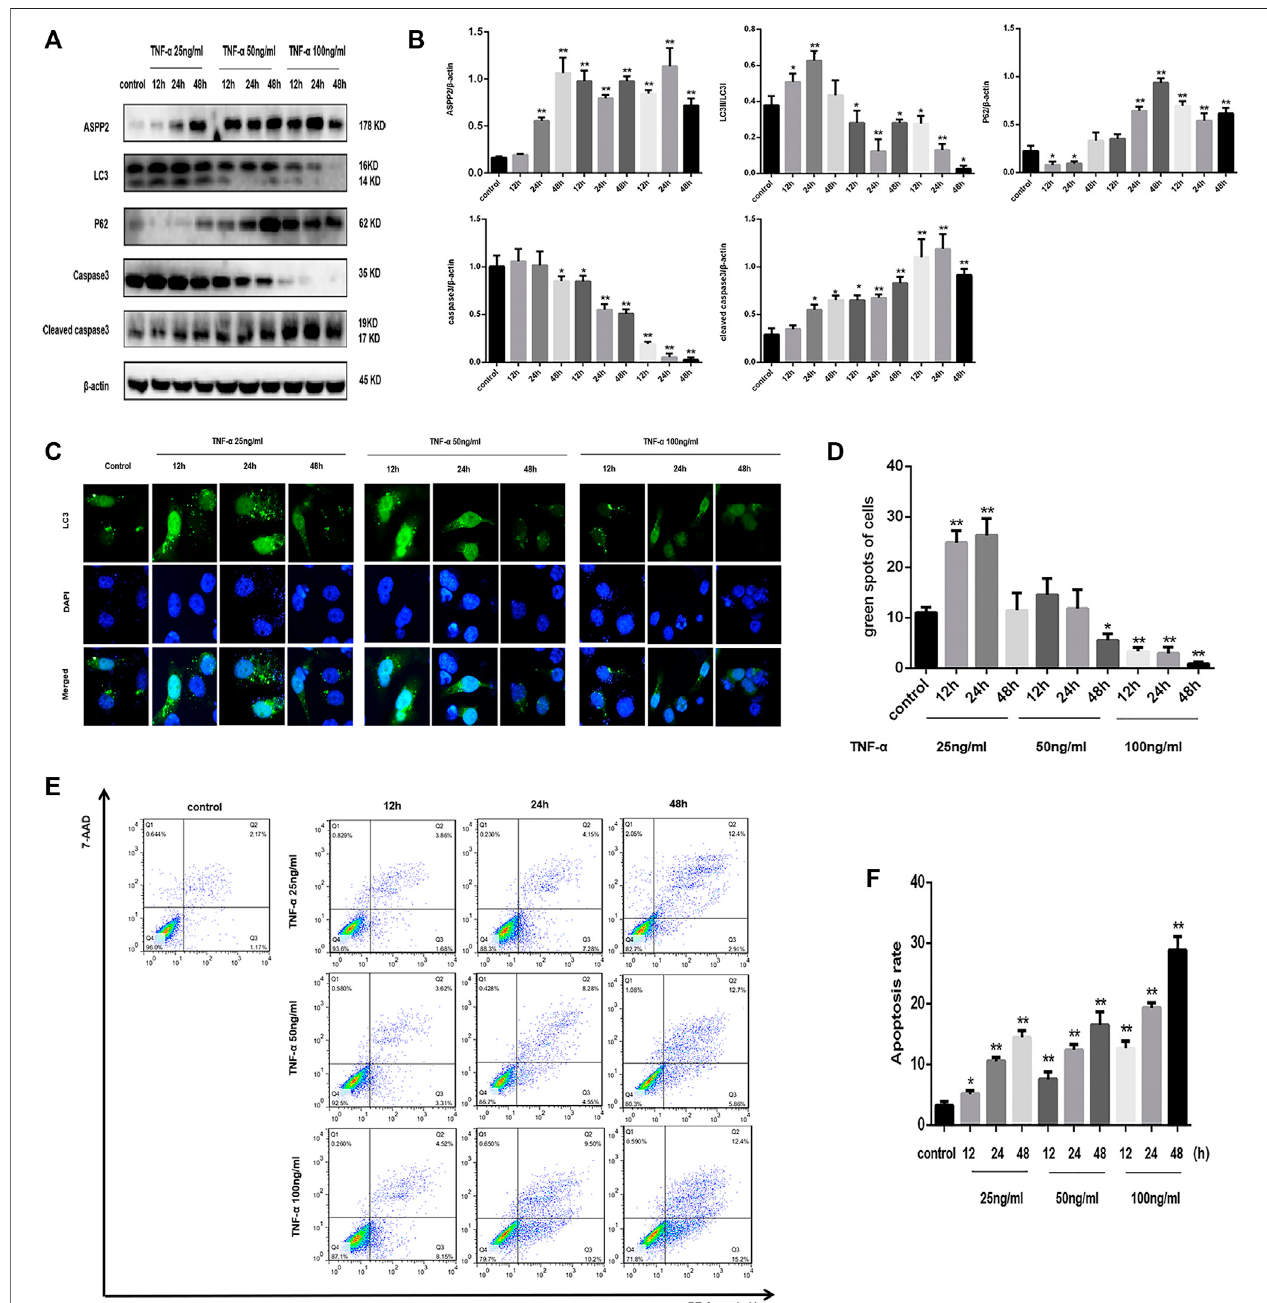
FIGURE 1 | TNF- α activated autophagy in low dose and induced apoptosis in high dose, but triggered ASPP2 expression throughout the course of experiment. HL7702 cells were treated with 25, 50, and 100 (ng/ml) TNF- α for 12, 24, and 48 h, respectively. In contrast, the control group was not treated with TNF- α . (A,B) Representative western blotting analysis of protein expression in HL7702 cells after TNF- α treatment. Quanti fi cations were normalized to β -actin and expressed as relative density. (C,D) A GFP-LC3 plasmid was transfected into cells and the representative fl uorescence image of cells was presented. The green spots of cells were manually quanti fi ed in fi ve randomly selected areas. (E,F) Representative apoptosis images were showed with PE and 7-AAD reagents by fl ow cytometry. The apoptosis rate was calculated using the proportion of early and late apoptotic cells in total cells. * p < 0.05; ** p < 0.01.